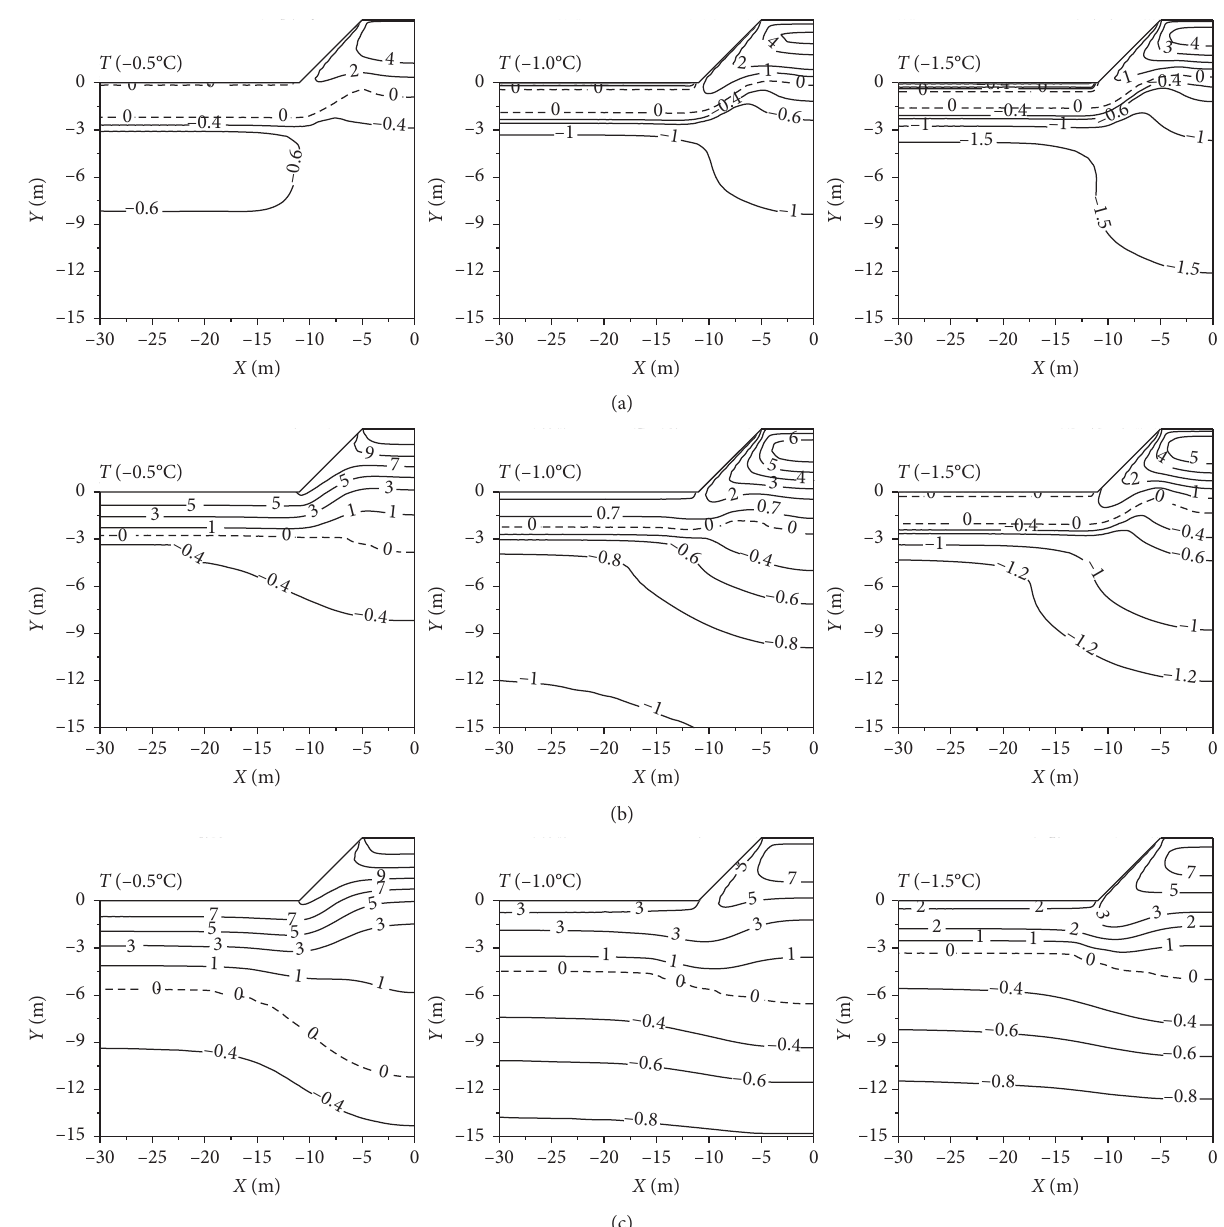
Figure 5: Distribution of the temperature field beneath the NSE under the annual ground temperature of − 0.5 ° C, − 1.0 ° C, and 1.5 ° C in October of the 5th, 20th, and 50th years (unit: ° C).